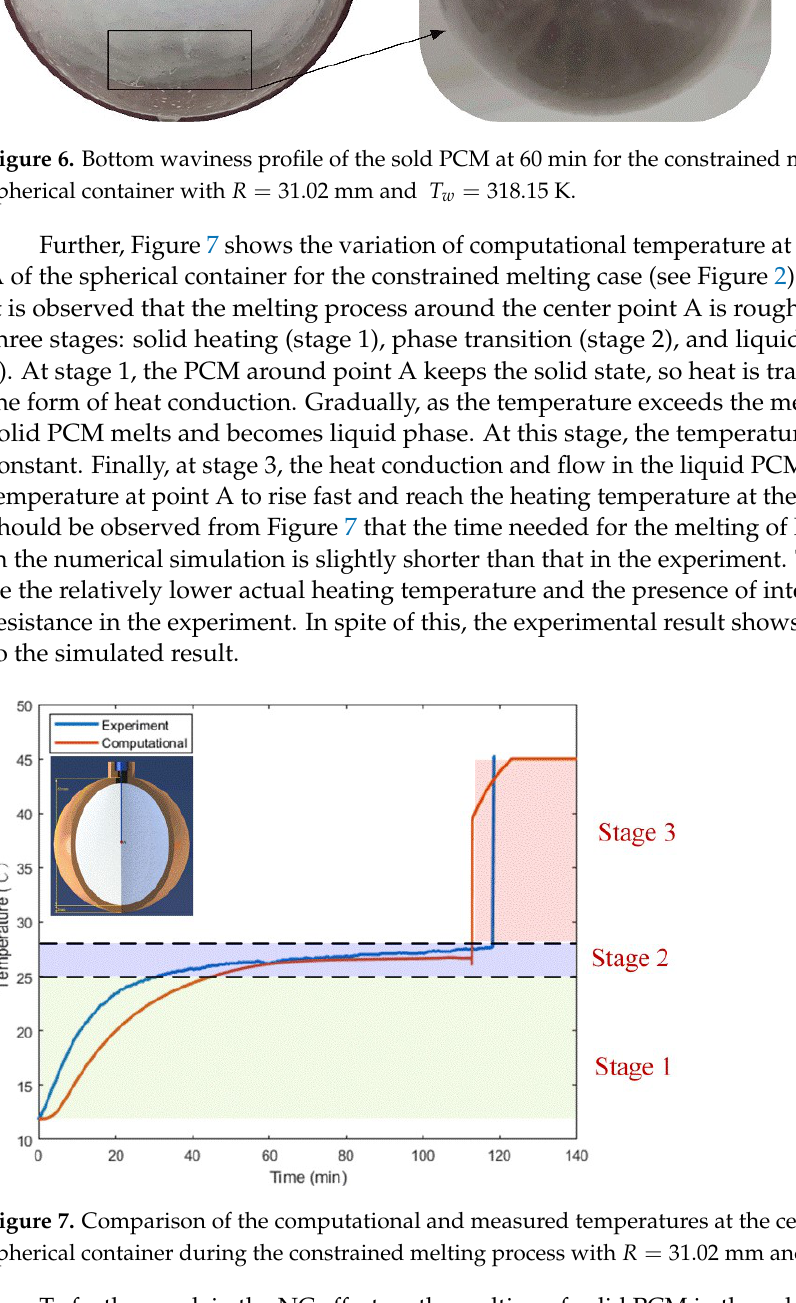
Figure 6. Bottom waviness profile of the sold PCM at 60 min for the constrained melting inside the spherical container with R = 31.02 mm and T w = 318.15 K.